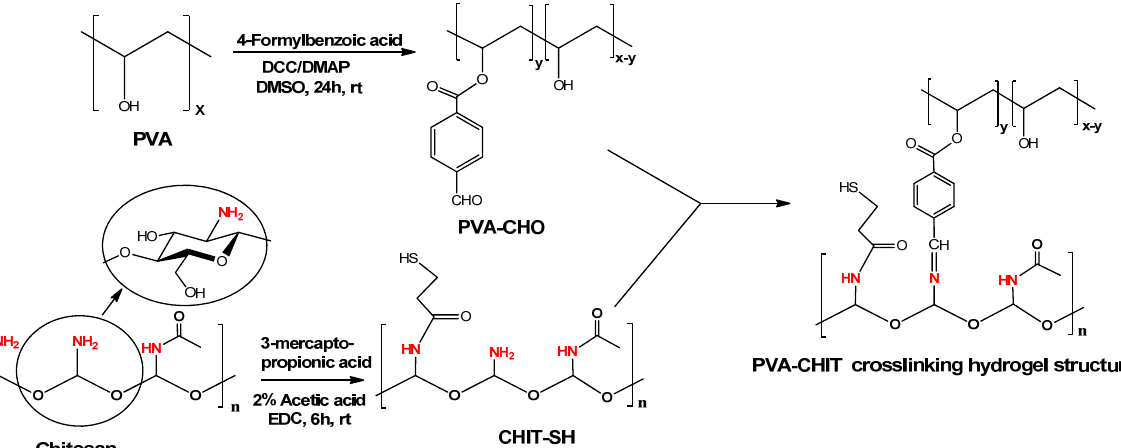
Figure 1. Scheme of synthesis of PVA-CHO and CHIT-SH as well as the crosslinking structure for- mation.